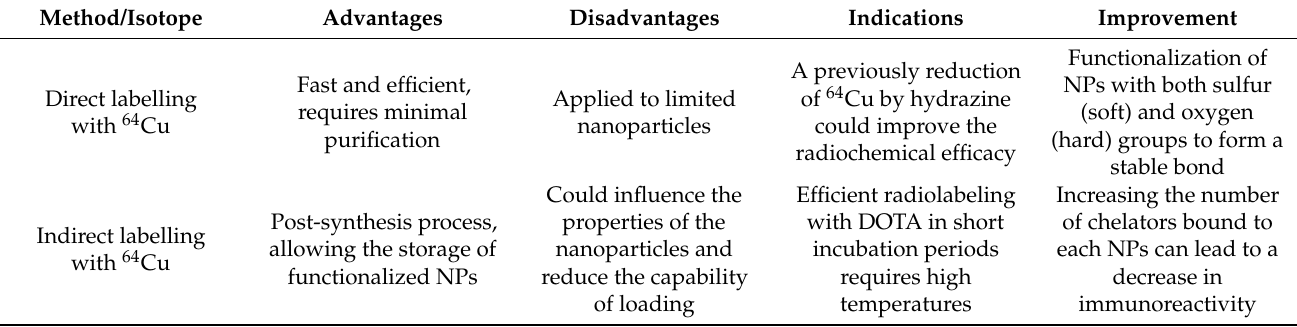
Table 1. Pros and cons of different methods for radiolabelling NPs with